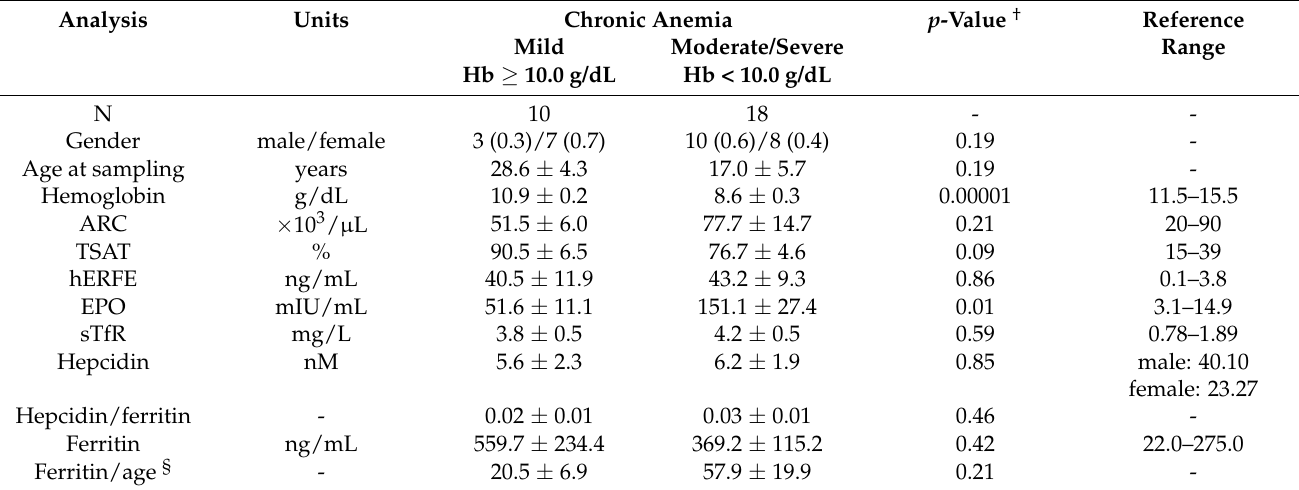
Table 1. CDA II patients enrolled in the study .